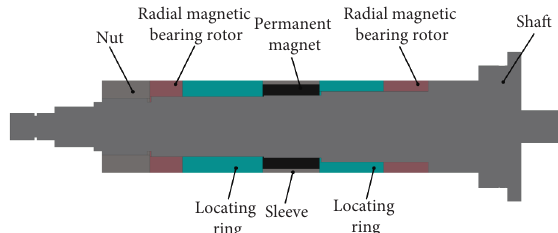
Figure 1: Model of the stepped rotor